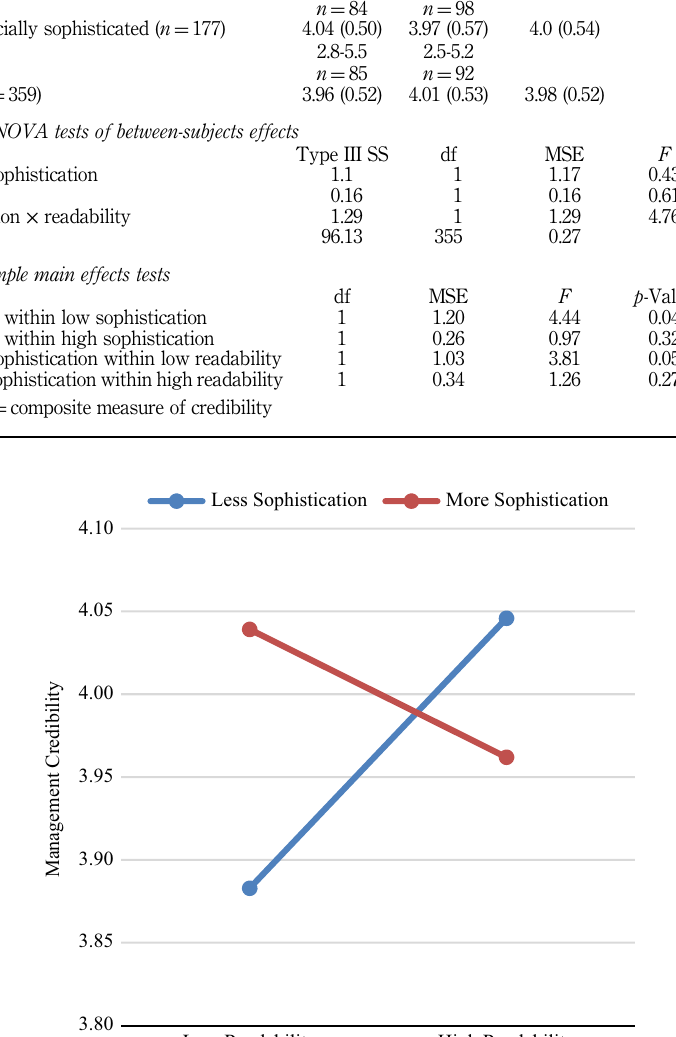
Figure 3. Management credibility by readability and sophistication